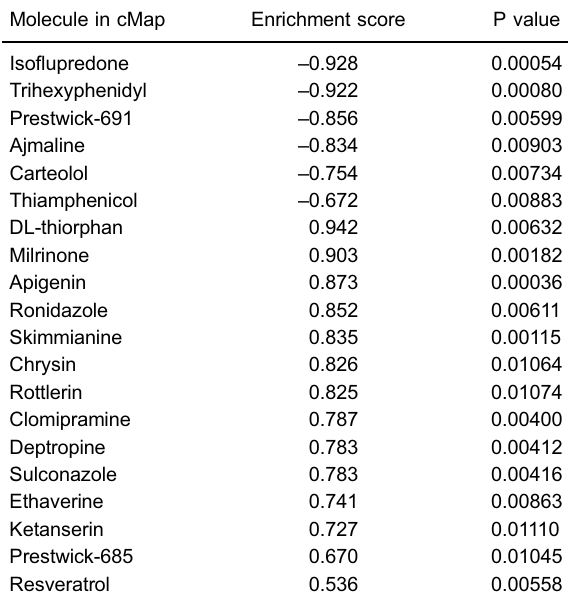
Table 3. Enriched signi fi cant small molecules. Molecule in